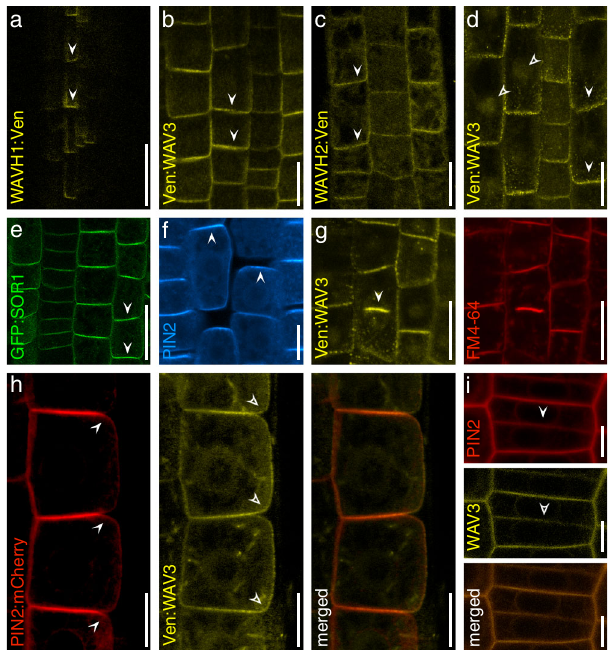
Fig.7|SubcellularlocalizationofWAV3/WAVH/SOR1reporterproteins.a Root meristem stele cells expressing WAVH1::WAVH1:Ven at 5 DAG. Root meristem epi- dermis cells of 5 DAG seedlings expressing WAV3::Ven:WAV3 ( b ); WAVH2::- WAVH2:Ven ( c ); XVE»Ven:WAV3 in presence of 2 μ M estradiol ( d ). Closed arrowheads indicate reporter localization proximal to the PM, open arrowheads indicateintracellularreportersignals. e SubcellularlocalizationofGFP:SOR1inroot meristemepidermiscellsof5DAG wavtriple35S::GFP:SOR1 seedlings(arrowheads). f PIN2 immunolocalization in root meristem epidermis cells of 5 DAG wav triple 35S::GFP:SOR1 seedlings (arrowheads). g Subcellular localization of Ven:WAV3 in a dividing root meristem cell of 5 DAG wav triple XVE»Ven:WAV3 (left, arrowhead indicates cell plate). FM4-64 co-staining was employed to highlight the emerging cell plate (right). h Localization of PIN2:mCherry and Ven:WAV3 in root meristem epidermis cells of 5 DAG PIN2::PIN2:mCherry XVE»Ven:WAV3 seedlings grown in presence of 2 μ M estradiol. Closed arrowheads indicate PIN2:mCherry polarity at the PM, whilst open arrowheads indicate polarity of Ven:WAV3. i Localization of PIN2:mCherry and Ven:WAV3 in a cytokinetic root meristem epidermis cells of 5 DAG PIN2::PIN2:mCherry XVE»Ven:WAV3 grown in presence of 2 μ M estradiol. Closed and open arrowheads indicate cell plate localization of PIN2:mCherry and Ven:WAV3,respectively.Threeindependentexperimentswere performed for( a – i ) with similar results. Scale bars: a – d , f =10 μ m; e =20 μ m; h , i =5 μ